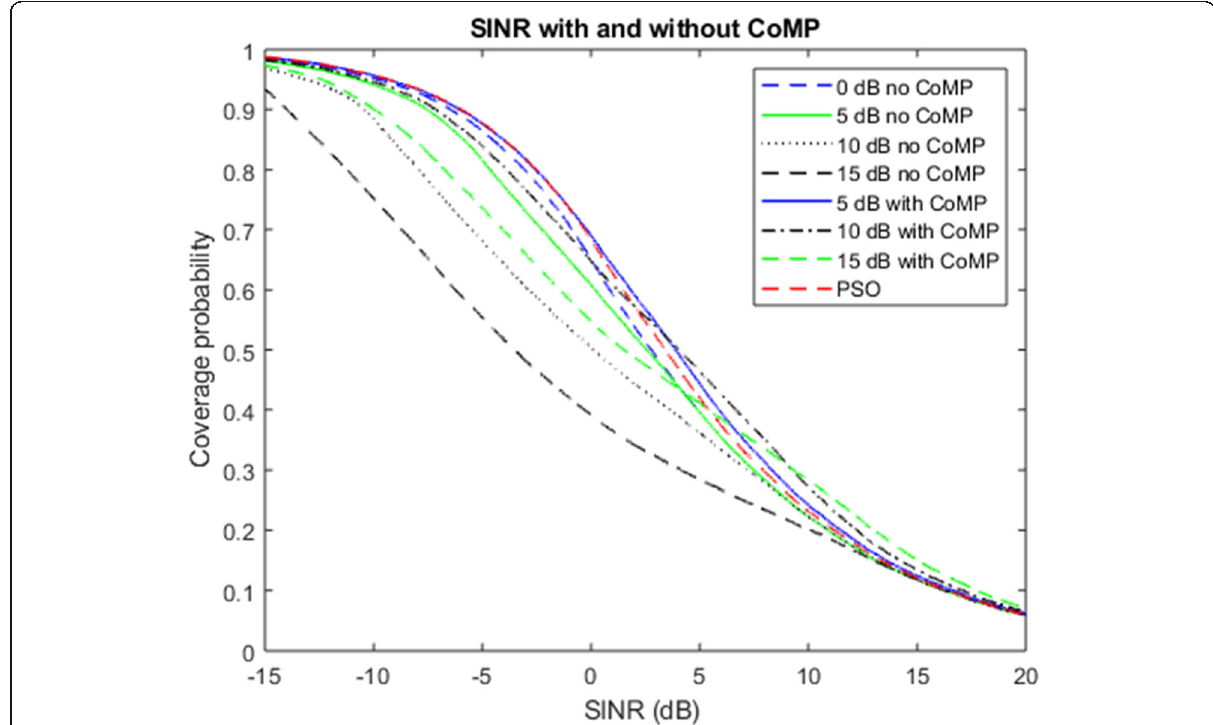
Fig. 4 Biased user association coverage probability with and without CoMP. This figure shows the coverage probability for biased user association with and with no CoMP. The figure shows that implementing coordinated multipoint significantly improve the coverage